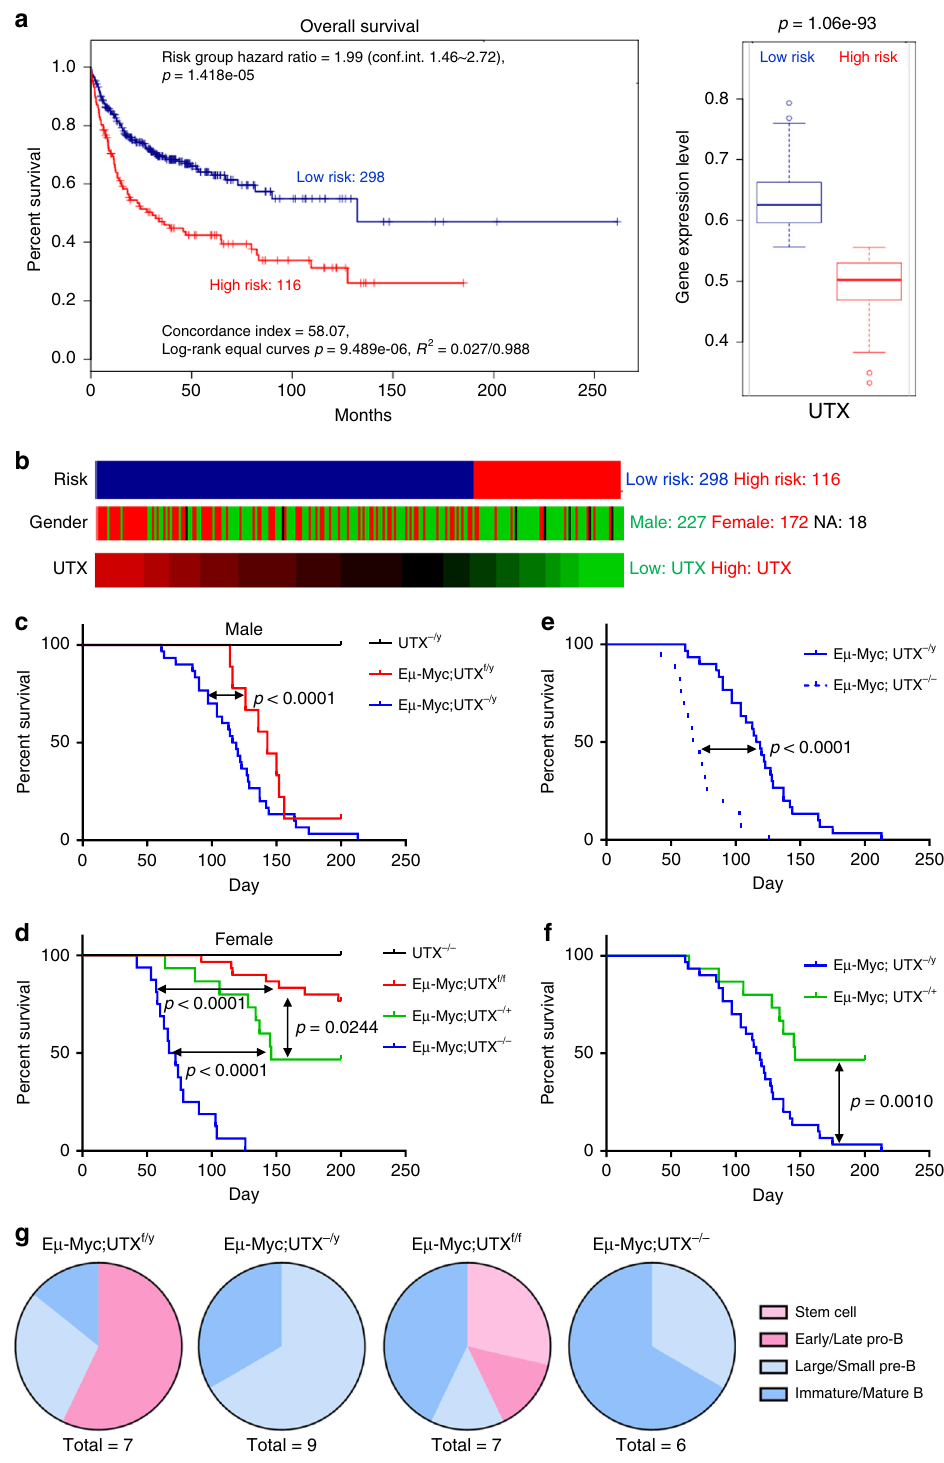
Fig. 1 UTX acts as an ‘ escape from X-inactivation tumor-suppressor ’ during E μ -Myc-induced lymphomagenesis. a Expression level of UTX in human lymphoma were correlated with risk and overall survival time. UTX expression status was used as the variable to test if it can predict patient survival. Green and red lines indicated low-risk ( n = 298) and high-risk ( n = 116) groups, respectively. Risk grouping was conducted through an optimization algorithm. Analysis was performed by SurvExpress. High-risk group was correlated with low expression of UTX. b Distribution of male and female patients in risk groups separated by UTX expression. Male were enriched in low expression of UTX indicated low risk, poor prognosis. Female were enriched in high expression of UTX indicated low risk, good prognosis. c Kaplan – Meier curves indicating the survival of male mice with each cohort, UTX − /y mice ( n = 19,black), E μ -Myc;UTX + /y mice ( n = 9, red), E μ -Myc;UTX − /y mice ( n = 30, blue). d Kaplan – Meier curves indicating the survival of female mice with each cohort, UTX − / − mice ( n = 19, black), E μ -Myc mice ( n = 30, red), E μ -Myc;UTX − / + mice ( n = 15, green), E μ -Myc;UTX − / − mice ( n = 16, blue). e Comparison of Kaplan – Meier curves of E μ -Myc;UTX − / − and E μ -Myc;UTX − /y . f Comparison of Kaplan – Meier curves of E μ -Myc;UTX − /y and E μ -Myc;UTX + / − . Statistical signi fi cance was determined using log-rank test for panel C to F. g Distribution of B cell differentiation stages for lymphomas from each